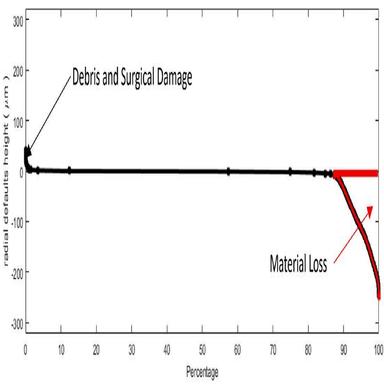
Abbott-Firestone curve showing detection of wear debris material loss.